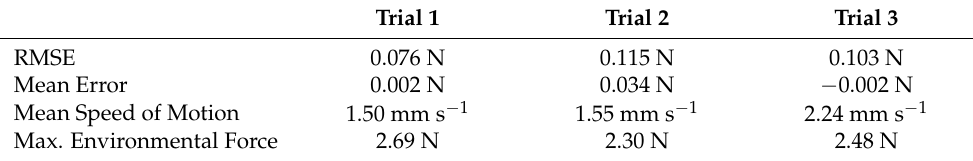
Figure 15. Individual spring and damping force components of the Hunt–Crossley environ- ment model. Table 6. RMSE and mean prediction error during palpation using the Hunt–Crossley virtual